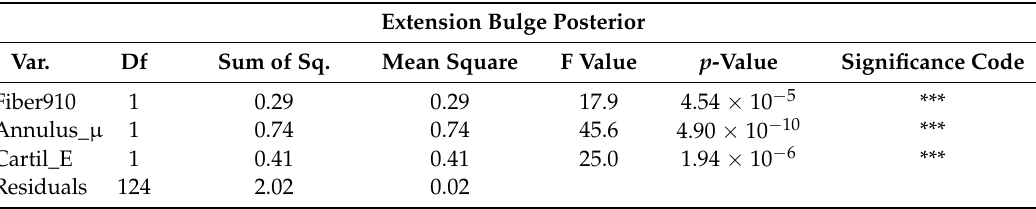
Table 17. ANOVA table for an extension bulge posterior linear model.